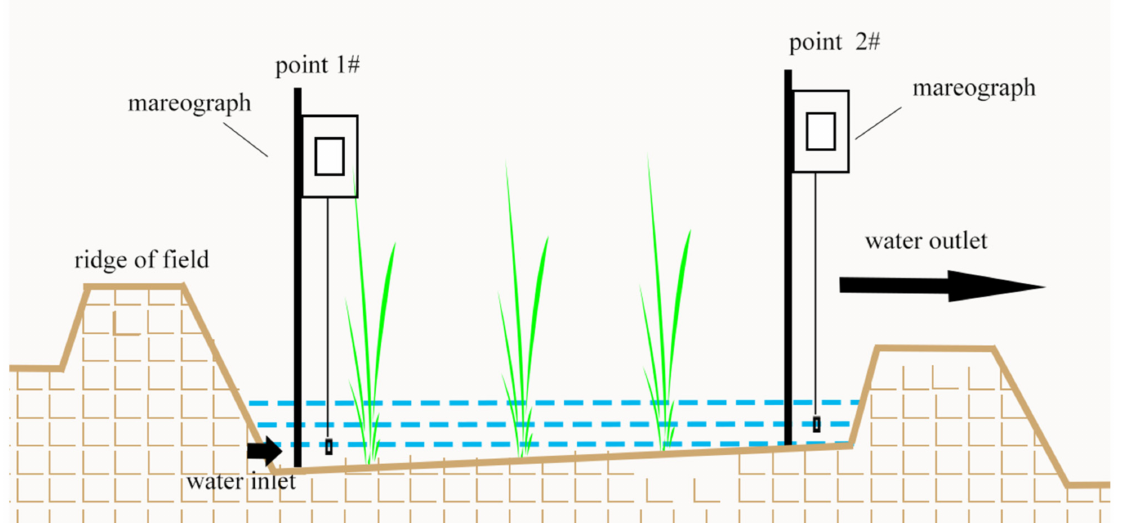
Figure 1. Schematic of experimental field